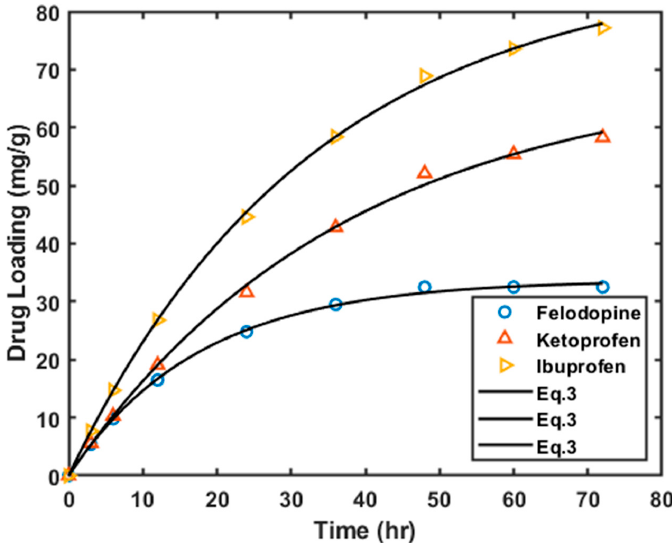
Figure 6. Loading kinetics of ibuprofen, ketoprofen and felodipine onto HKUST ‐ 1.